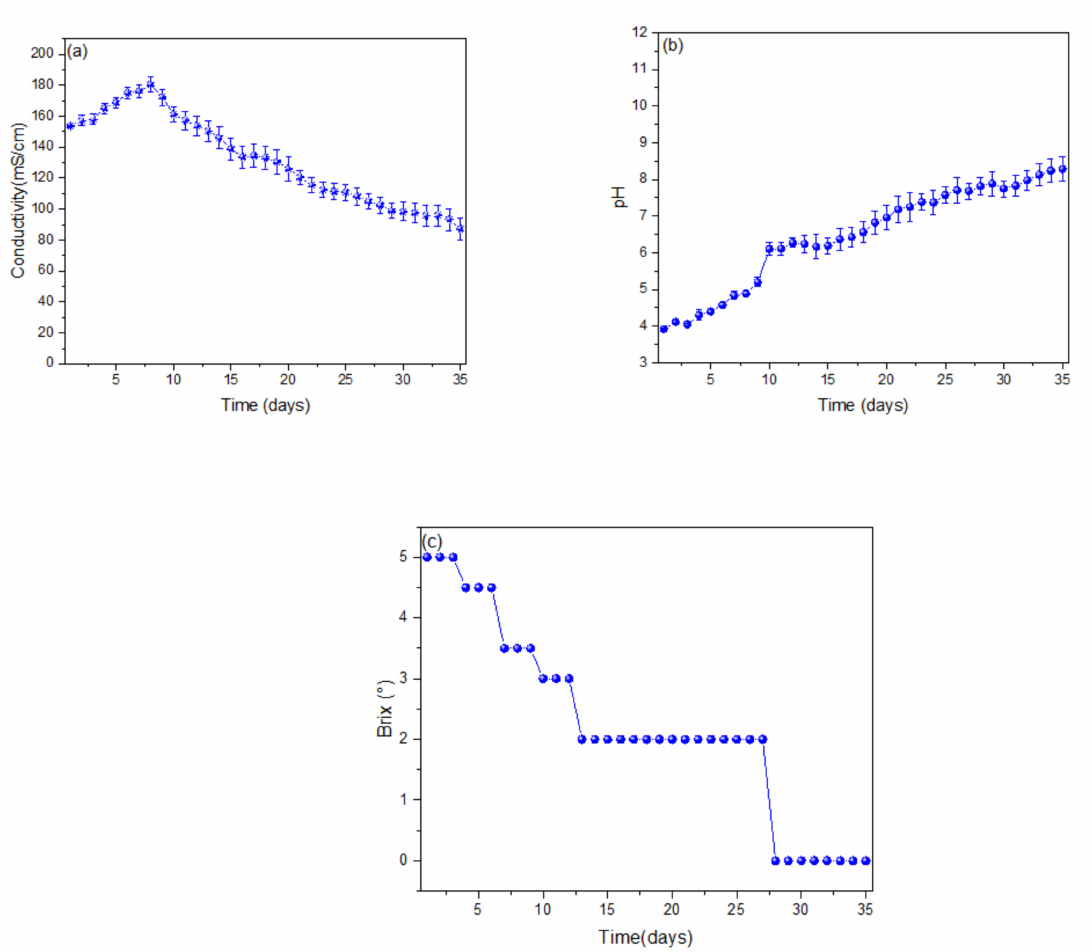
Figure 3. Monitoring of ( a ) conductivity, ( b ) pH and ( c ) brix parameters of